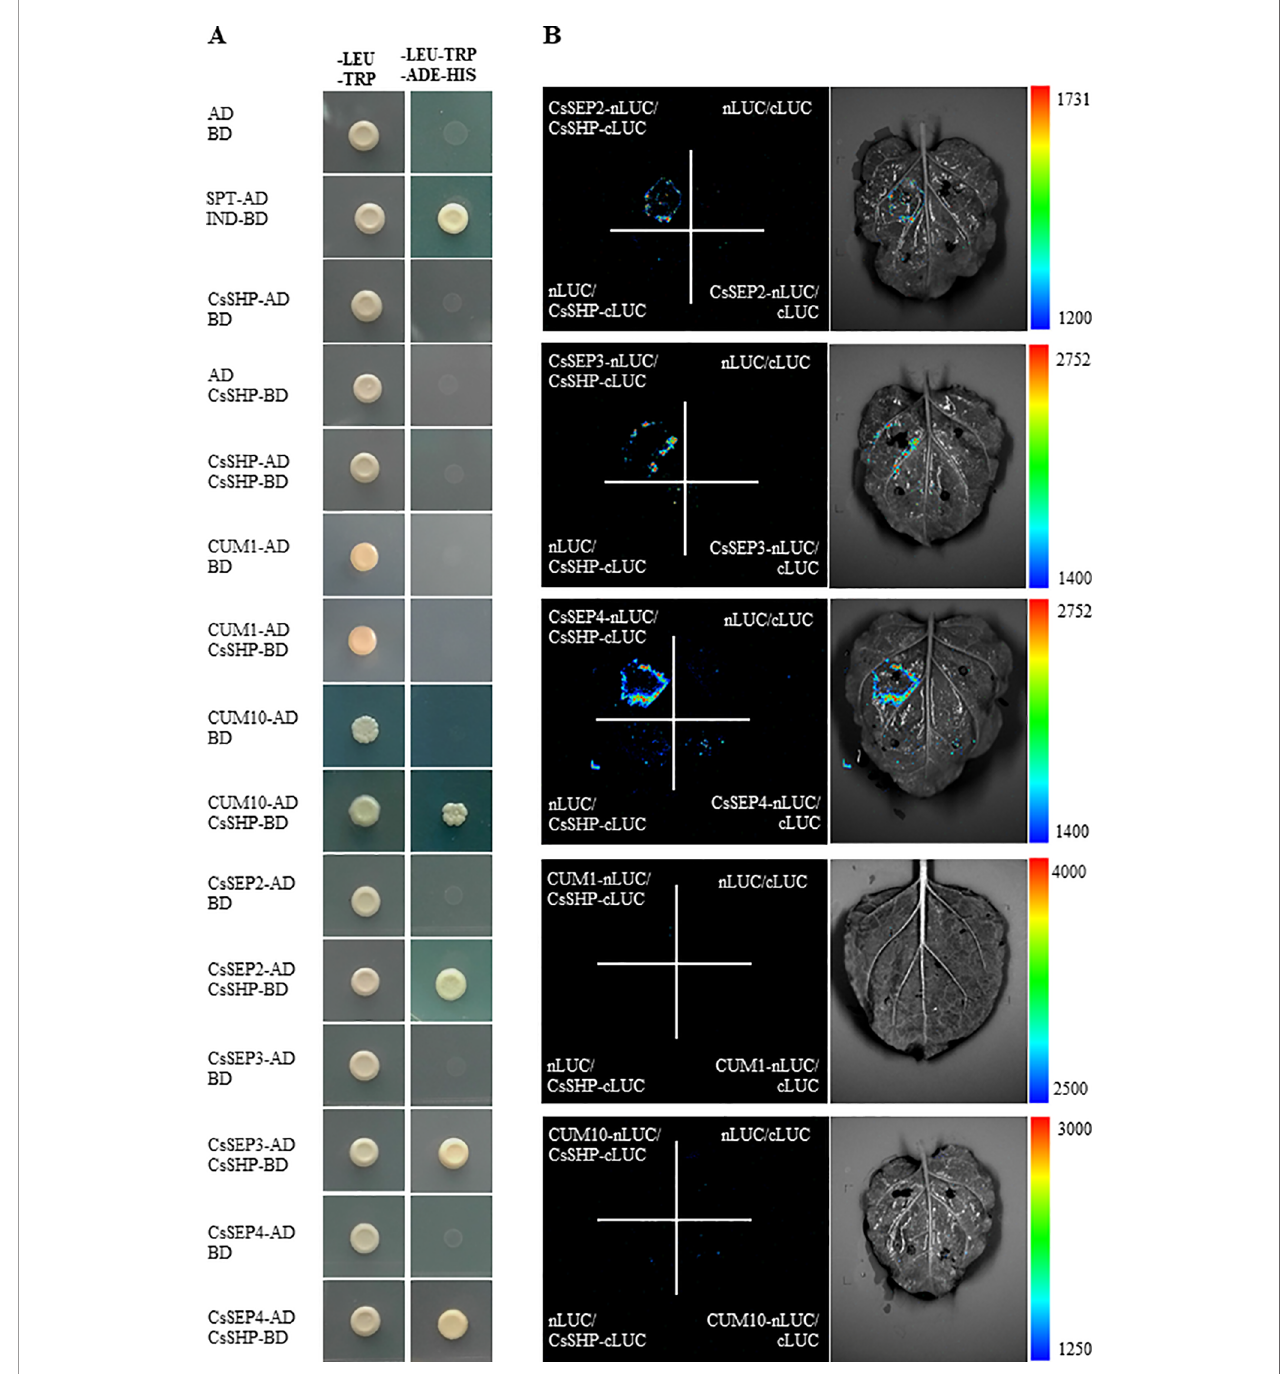
FIGURE 5 | Physical interactions of CsSHP with CsSEP2, CsSEP3, and CsSEP4. (A) Yeast two-hybrid assay. The combination of SPT-AD and IND-BD was used as a positive control. (B) Luciferase (LUC) complementation imaging